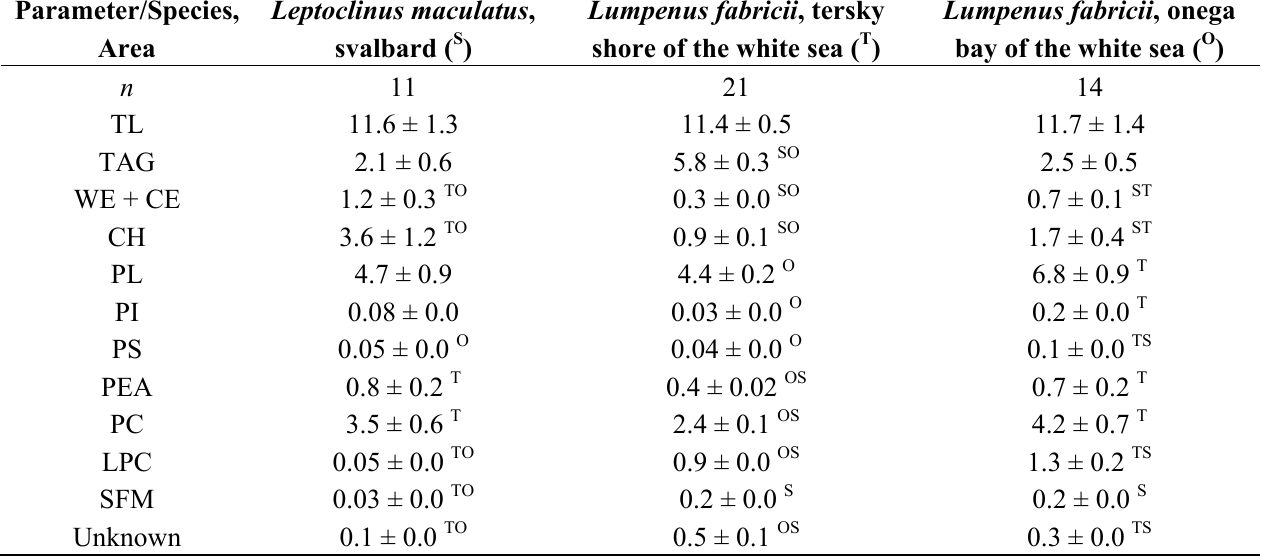
Table 1. Total lipids, triacylglycerols, wax esters, cholesterol esters, cholesterol, total phospholipids and separate phospholipids (% dry weight [dw]) in flesh of Leptoclinus maculatus from Svalbard (Isfjord) and Lumpenus fabricii from the White Sea (Onega Bay and Tersky Shore). Leptoclinus maculatus , Lumpenus fabricii , tersky shore of the white sea ( T